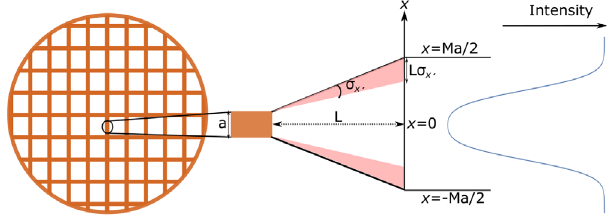
FIG. 2. A schematic of the beam propagating from the TEM grid to the screen, showing how it spreads by σ